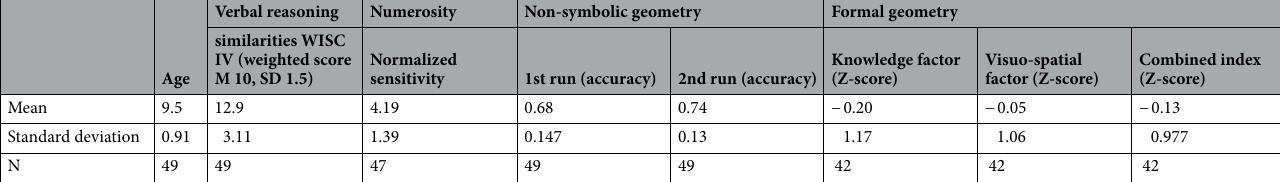
Table 1. Descriptive statistics of the sample characteristics and results. The table shows children age and scores on the different tests evaluating verbal reasoning, numerosity discrimination, non-symbolic and formal geometry. Sample size is also